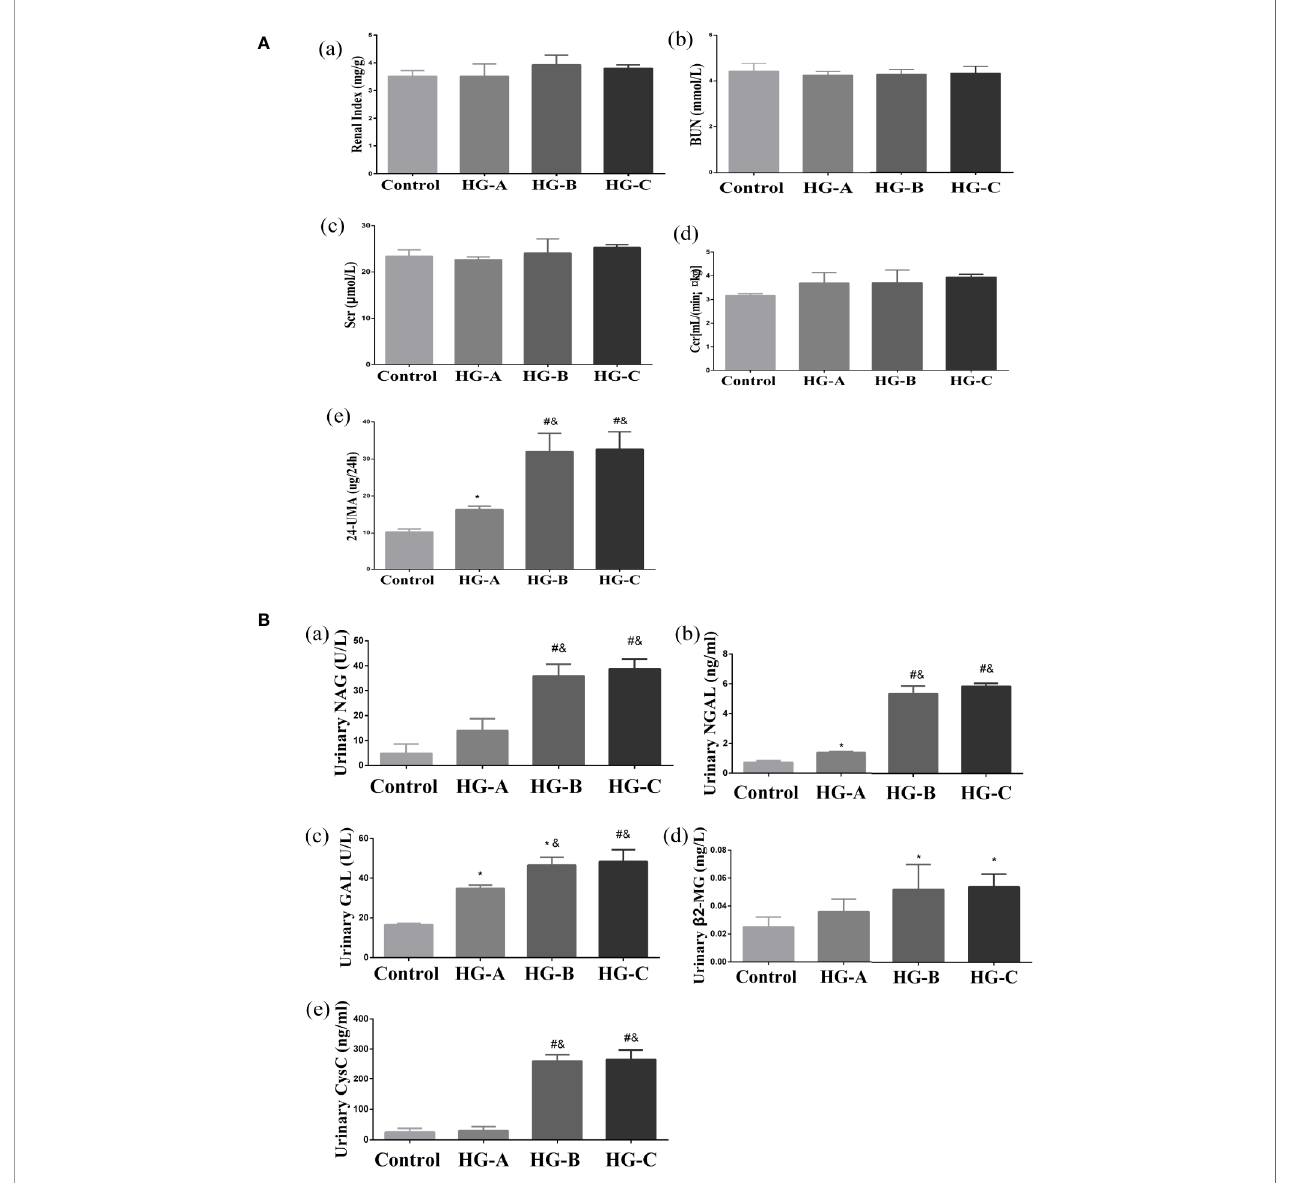
FIGURE 3 | Renal glomerular function, 24-h UMA and renal tubular function alterations. N = 10 in each group. (A) Renal glomerular function and 24-h UMA changes. (B) Renal tubular function alterations. Values were expressed as means ± SD in each group. * P < 0.05 vs. Control; # P < 0.001 vs. Control; & P < 0.05 vs. HG-A. Control, control group; HG-A, hyperglycemia group A; HG-B, hyperglycemia group B; HG-C, hyperglycemia group C. BUN, blood urea nitrogen; Scr, serum creatinine; Ccr, creatinine clearance rate; 24-h UMA, 24-h urinary microalbumin; NAG, N-acetyl- b -D-glucosaminidase; NGAL, neutrophil gelatinase-associated lipocalin; GAL, b -D-galactosidase; b 2-MG, b 2-microglobulin; CysC, Cystatin